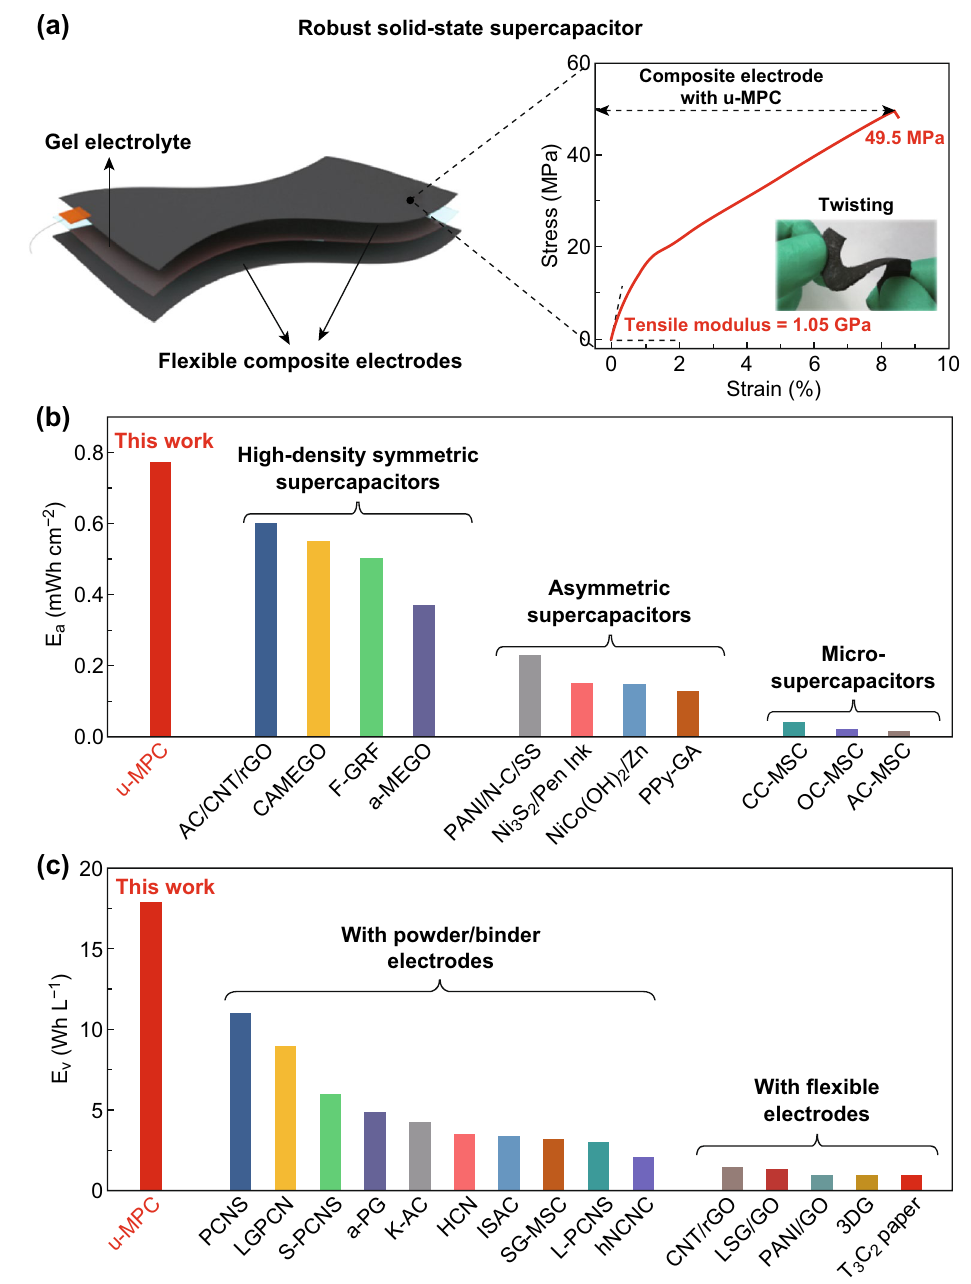
Fig. 6 Performance of robust symmetric supercapacitors. a Schematic structure of robust symmetric supercapacitor and mechanical perfor‑ mance of composite electrode with a photograph of double‑twisting composite electrode inset. Comparison of areal energy density ( b ) and volumetric energy density ( c ) with other reported work ( AC/CNT/rGO activated carbon/carbon nanotube/reduced graphene oxide, CAMEGO compressed activated microwave‑expanded graphene oxide, F-GRF multilayer‑folded graphene ribbon film, a-MEGO activated microwave‑ expanded graphene oxide, PANI/N-C/SS polyaniline/nitrogen‑doped carbon coated SS mesh, Ni 3 S 2 /Pen ink Ni 3 S 2 nanorods/Pen ink, NiCo(OH) 2 / Zn NiCo(OH) PPy-GA polypyrrole–graphene aerogel, CC-MSC carbide‑derived carbon‑micro‑supercapacitor, OC-MSC 2 /Zn anode,